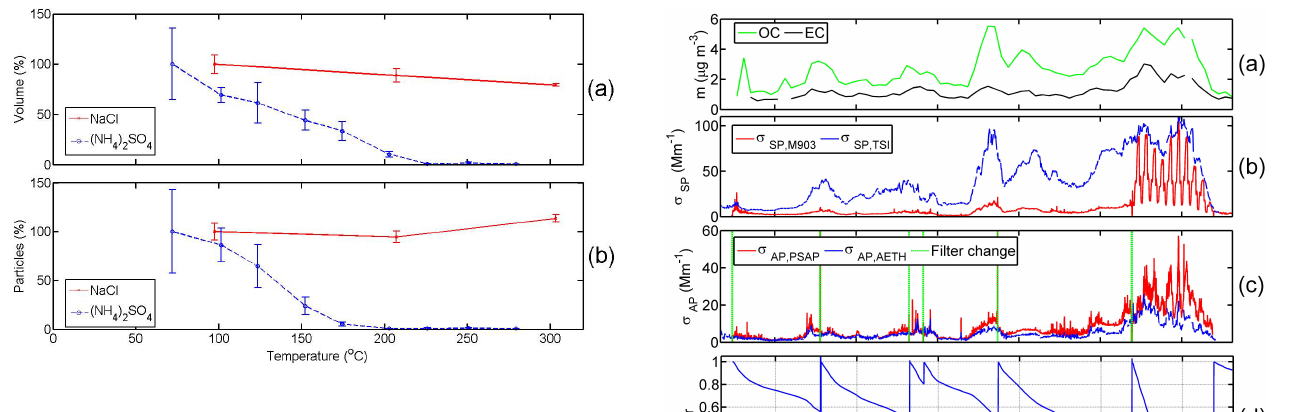
Fig. 2. The volume (a) and particle number (b) fractions left after the laboratory generated aerosol had been heated to different tem- peratures. The error bars are the standard deviation of the calculated values for a certain temperature.